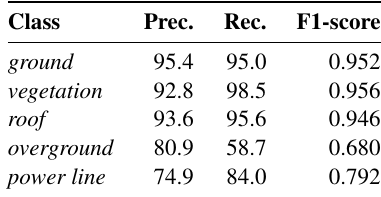
Table 2. Precision (%), recall (%) and F1-score achieved in the test set for each class.